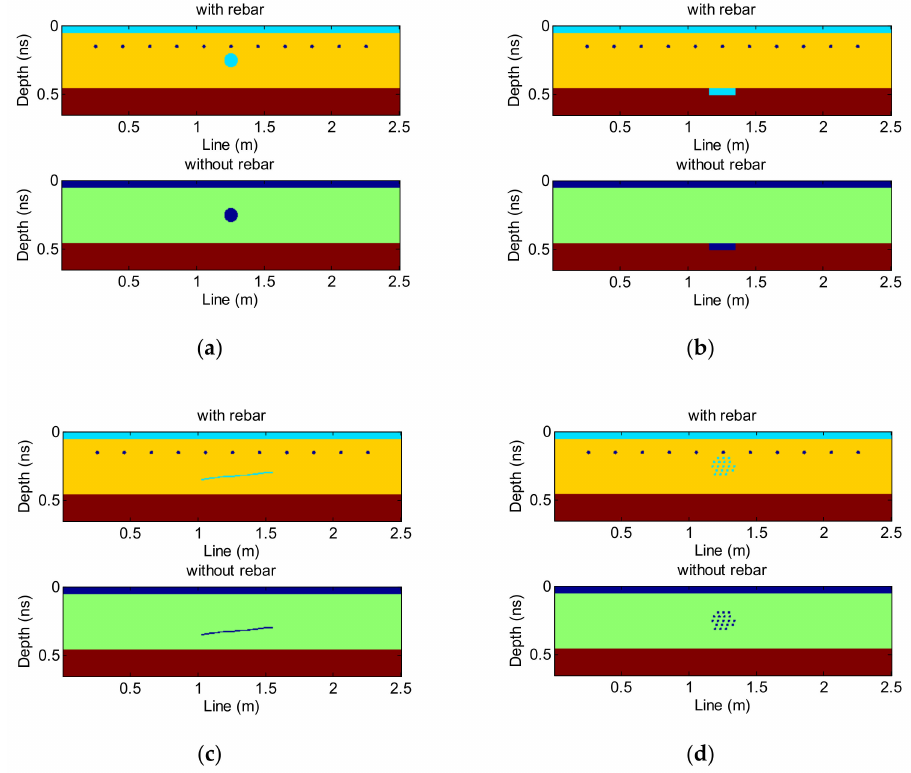
Figure 8. Hidden disease model: ( a ) void, ( b ) cavity, ( c ) crack, and ( d ) lack of density.